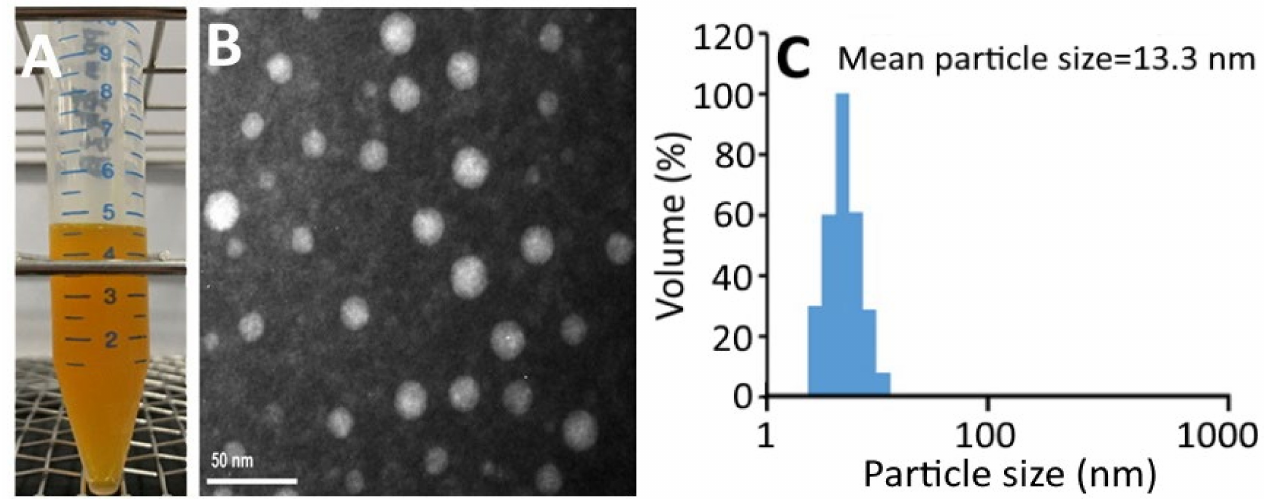
Figure 2. Carotenoid nanoemulsion from pomelo leaves ( A ) and its transmission electron microscope image showing round shaped particle with a mean particle size of 16 nm ( B ) as well as the particle size distribution obtained by DLS ( C